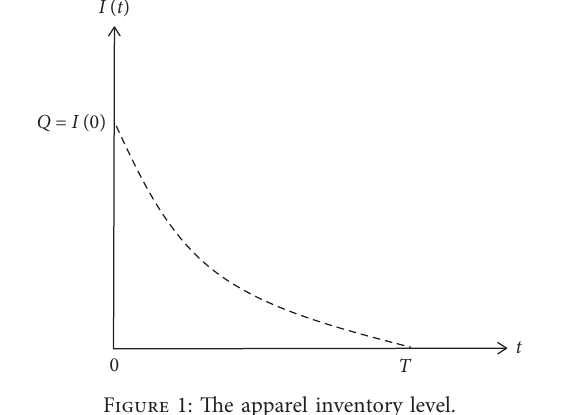
Figure 1: The apparel inventory level.